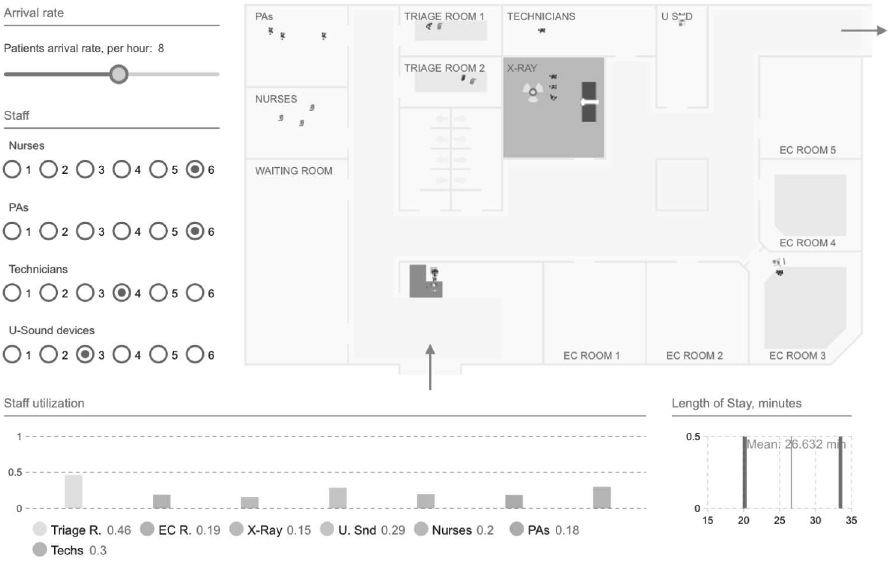
Figure 4. Emergency department discrete-event simulation model – 2D view (Anylogic,